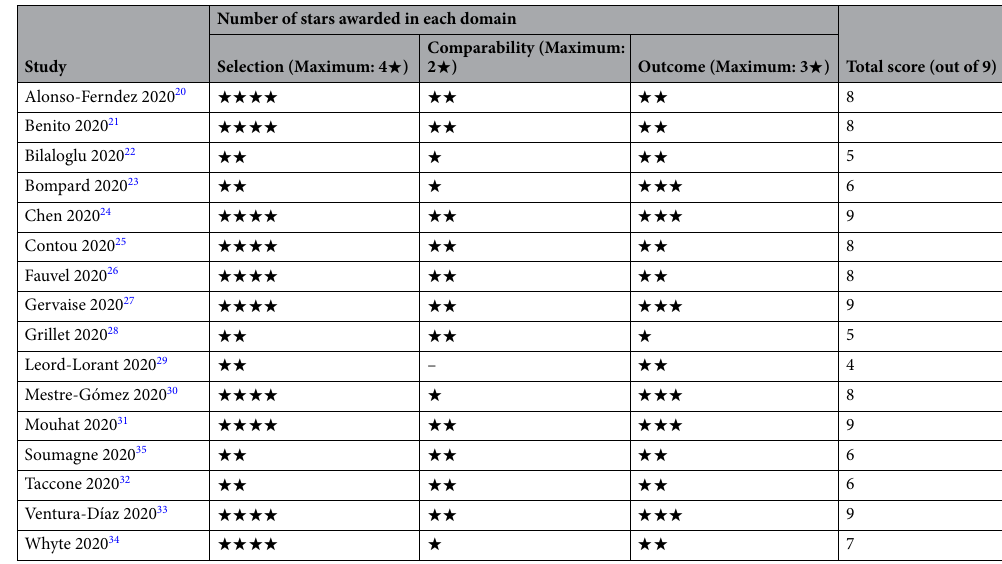
Table 2. Quality of included studies assessed with Newcastle Ottawa scale (n = 16). A maximum of four, three, and two stars were assigned to the Selection, Comparability, and Outcome domains, respectively. The higher the number of stars, the better the quality of the study (i.e., up to nine stars for highest quality studies). For the second item of the Outcome domain, we awarded one star to a study if the patients were discharged from hospital or succumbed to the disease. For non-hospitalised patients or lack of relevant information (e.g., discharge or fatality) for inpatients, no star was assigned with the assumption of inadequate follow-up. One star was given to the last item of the Outcome domain for (1) studies with a follow-up rate ≥ 80%, or (2) those with a follow-up rate < 80% but including a description of lack of significant difference in demographic characteristics between the follow-up and lost-to-follow-up